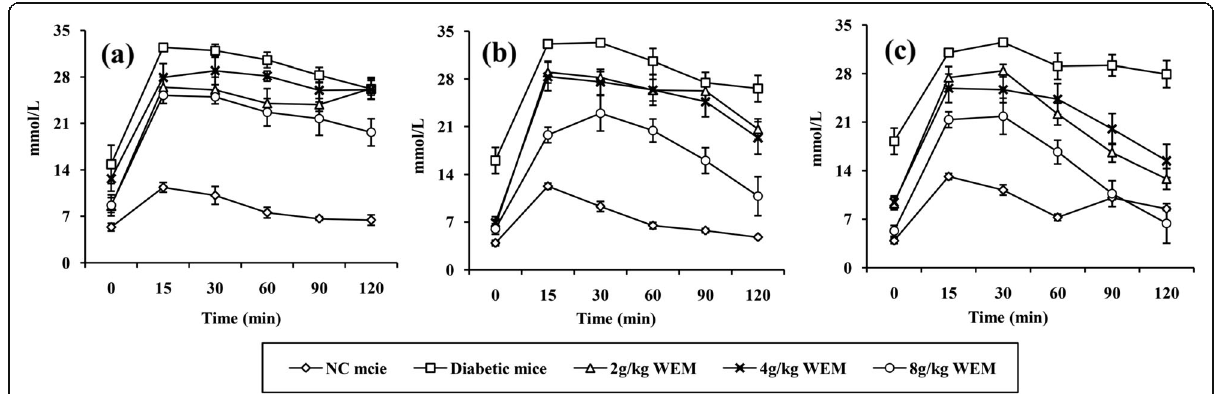
Fig. 2 Blood glucose concentrations during the oral glucose tolerance tests (OGTTs) following the treatment for 6 ( a ), 8 ( b ) and 10 ( c ) weeks. Results are means ± SEM ( n = 6)